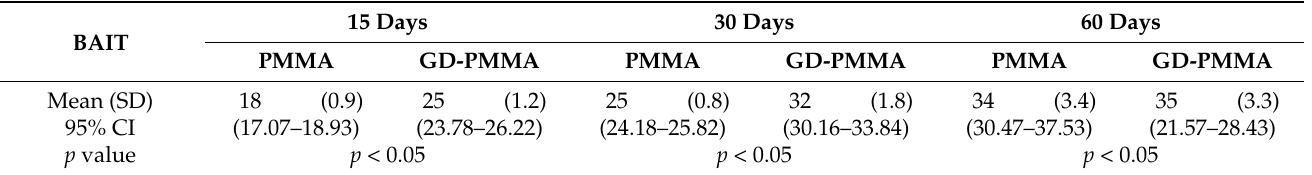
Table 2. Summary of histomorphometric micro-CT variables bone area inner threads (BAIT) between the PMMA implants group and GD-PMMA implants group (Kruskal Wallis followed by the Bunn’s test).